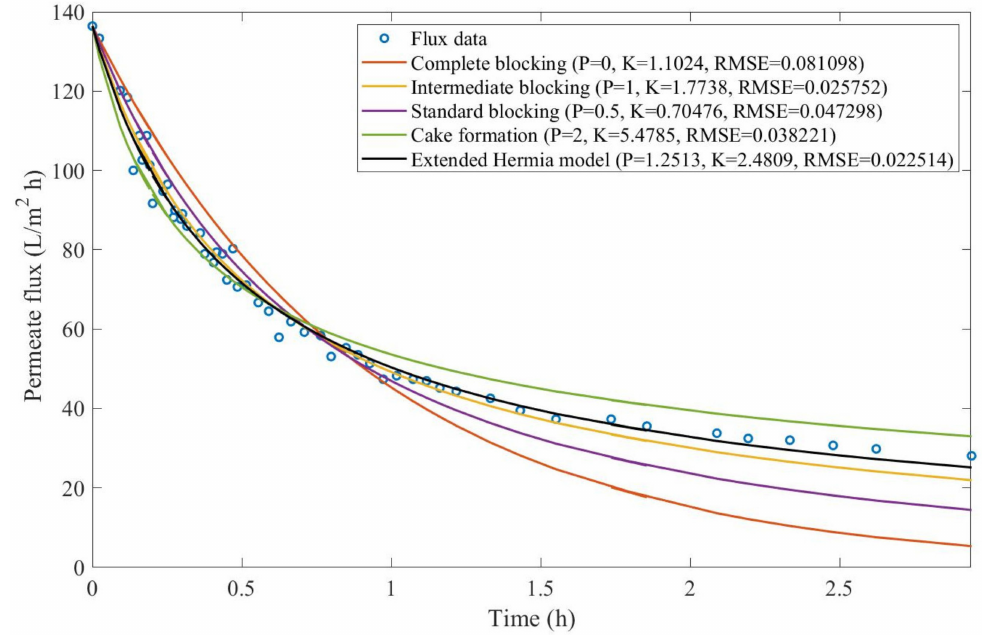
Figure A10. Model fitting for corn syrup microfiltration with CM05 at 0.5 m/s and 50 kPa considering the four original pore-blocking mechanisms and the extended Hermia model (2).